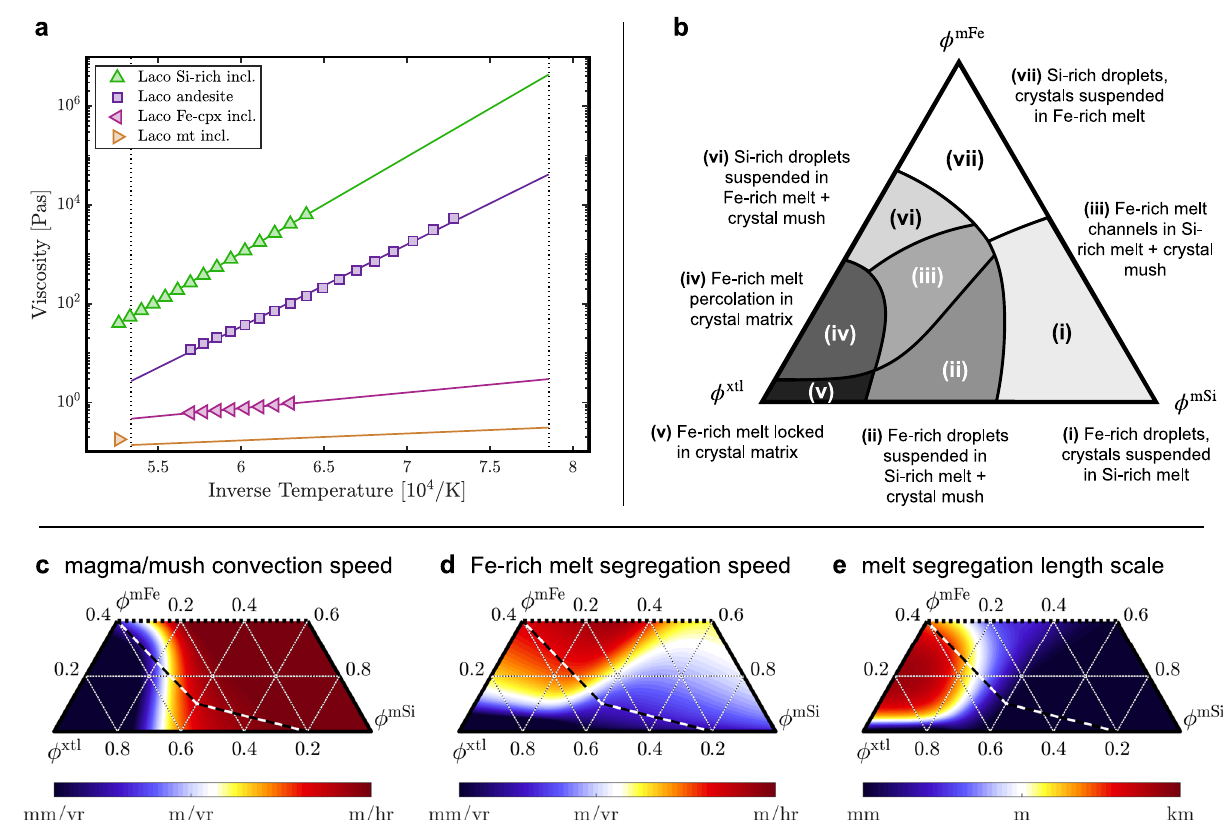
Fig. 4 |Viscometryand scalinganalysispertaining tooremeltseparationfrom parent magma body. a Viscometry results (symbols) with fi tted model (lines) for rhyolite(green),andesite(purple),Fe-clinopyroxene(pink),andmagnetite(amber) compositions (seeTable 1 and Supplementary Table 1); b regime diagram of three- phase fl ow between Si-rich melt ( ϕ mSi ), Fe-rich melt ( ϕ mFe ), and phenocryst ( ϕ xtl )